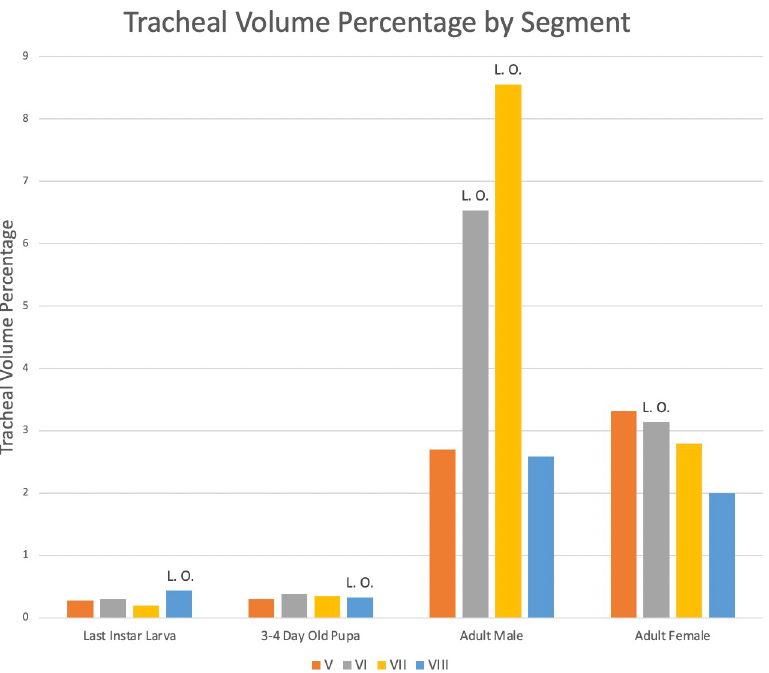
Fig 20. Tracheal volume percent by abdominal segment in larva, pupa, adult male, and adult female Photinus pyralis . “L. O.” indicates the presence of a light organ on that segment.